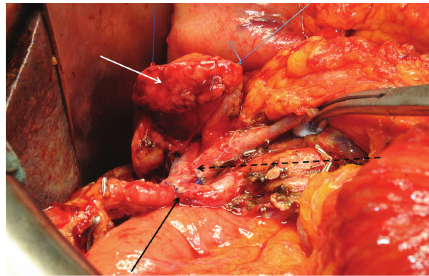
Figure 2: Intraoperative view in combined arterial and venous resection. Arterial anastomosis after resection of a replaced right liver artery (black arrow) infiltrated by the resected PDAC. Portal vein anastomosis (broken black arrow) and pancreatic remnant (white arrow) before completing the